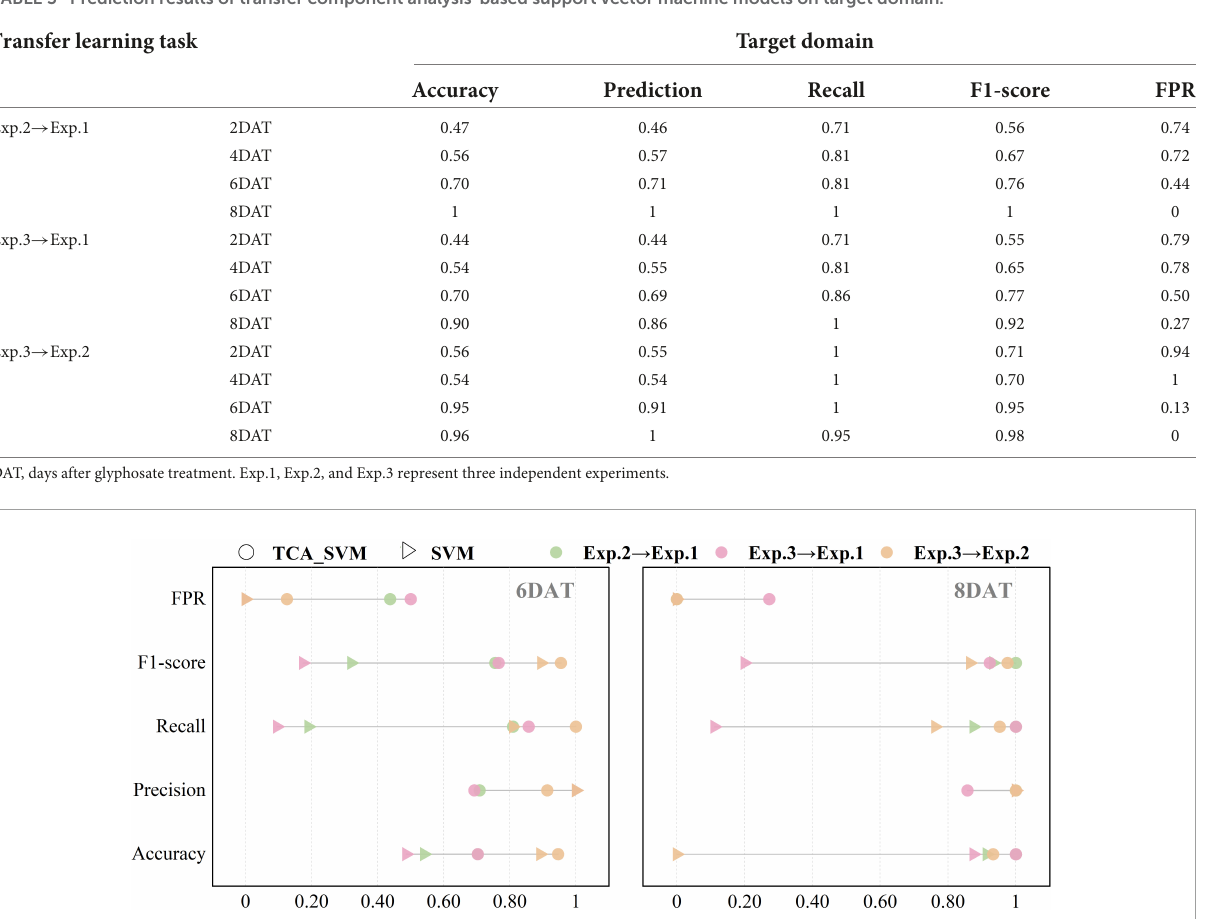
FIGURE4 Prediction results of support vector machine models in target domain before and after using transfer component analysis algorithm. TCA_SVM, transfer component analysis-based support vector machine